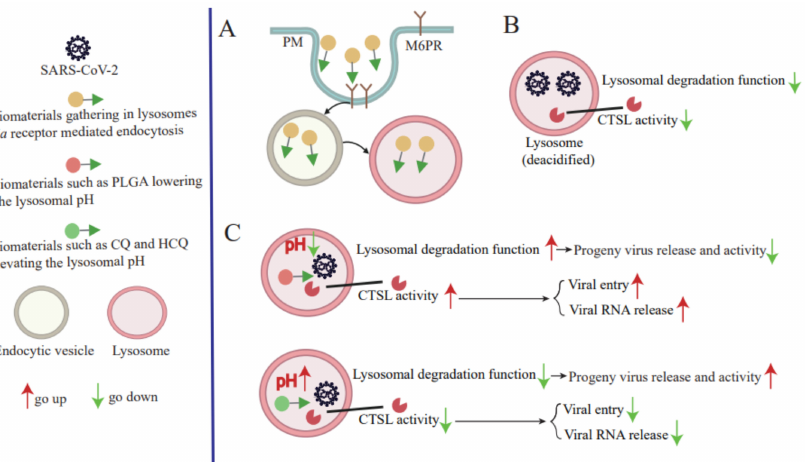
Figure 3. SARS-CoV-2 replication can be inhibited by modulating lysosomal pH. ( A ) Lysoso- motropic compounds allow for lysosomal localization via receptor-mediated endocytosis. ( B ) SARS- CoV-2 infection leads to lysosome deacidification. ( C ) The antiviral agent for SARS-CoV-2 is a complex process of lysosomal pH